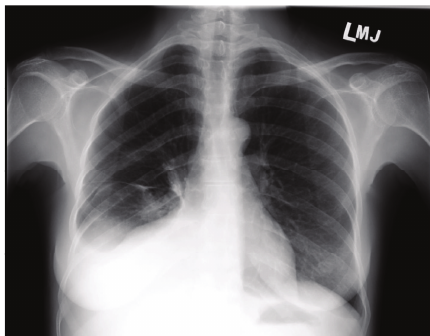
Figure 2: Chest X-ray showing improvement of pleural effusions after abdominal paracentesis, suggesting that the fluid was commu- nicating between pleural and peritoneal